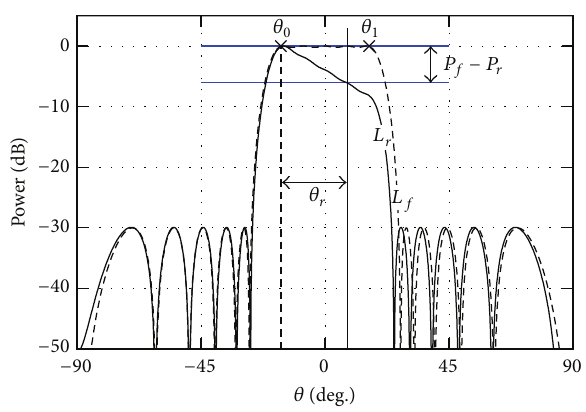
Figure 1: Shaped beam patterns of a 16 -element equispaced linear array. The flat-top pattern ( 𝐿 𝑓 ) is used to normalize the received power at a given point in time while the ramp-shaped pattern ( 𝐿 𝑟 ) is used to relate the power to an